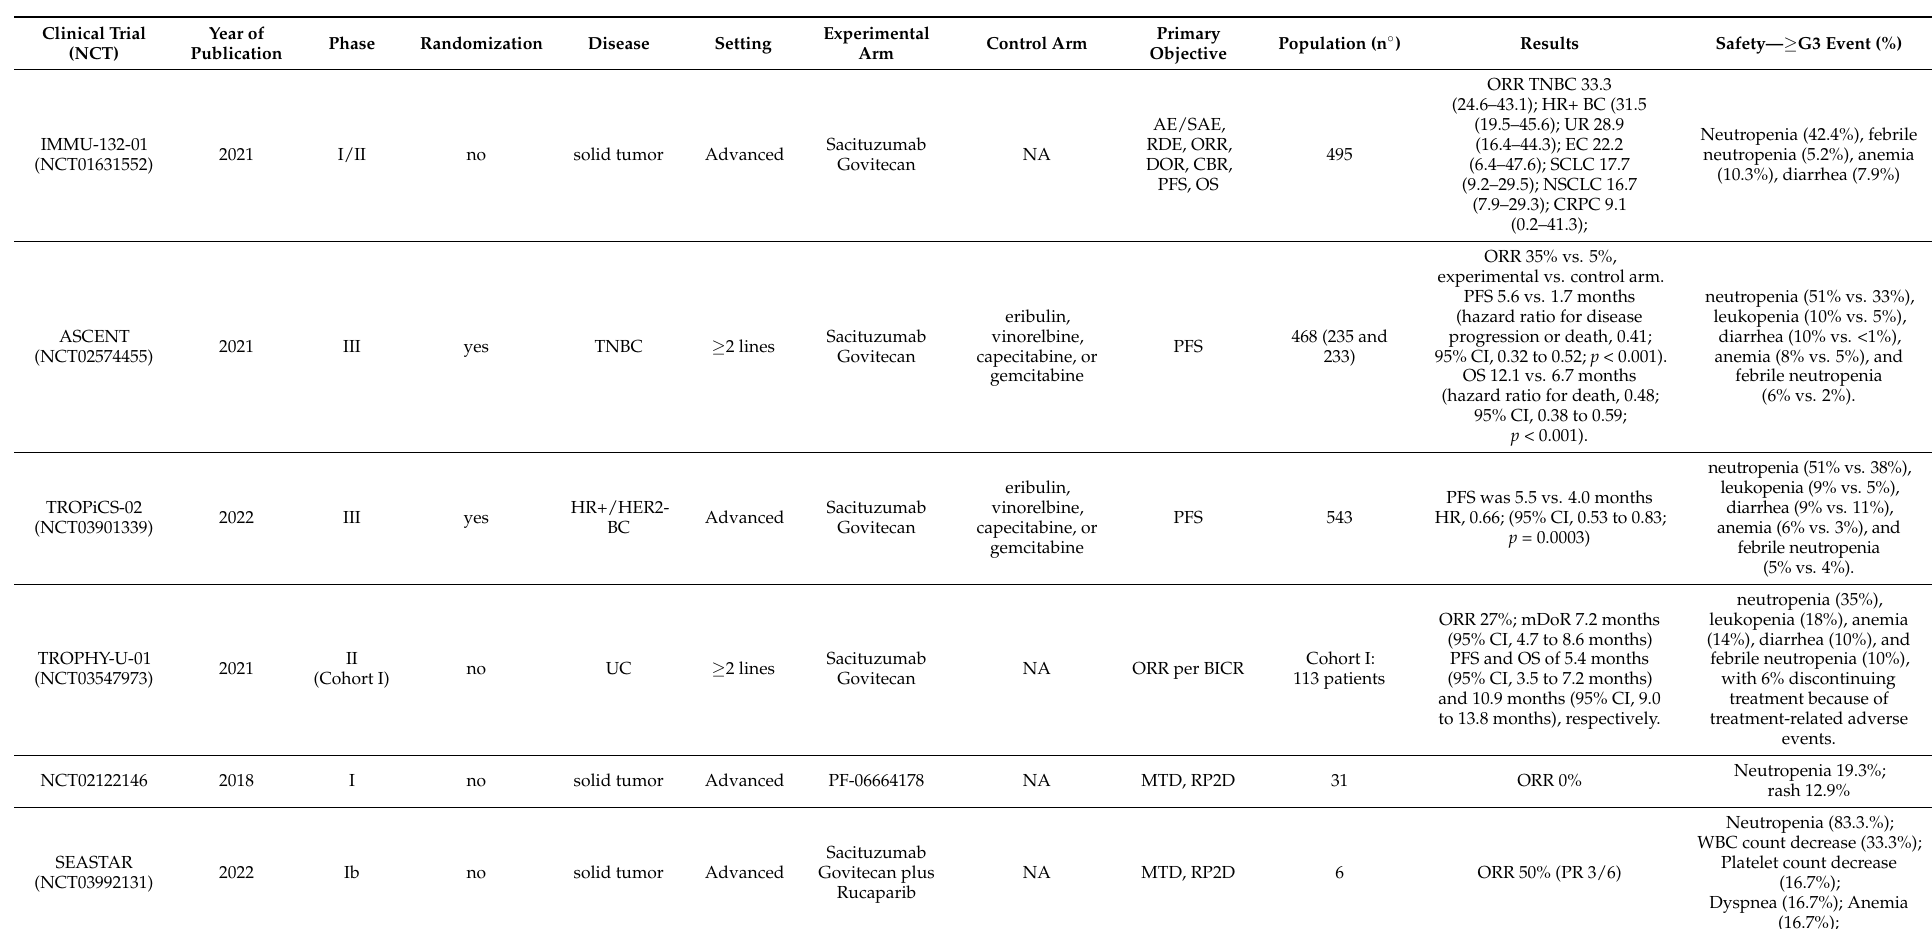
Table 1. Published clinical trials with anti-TROP2